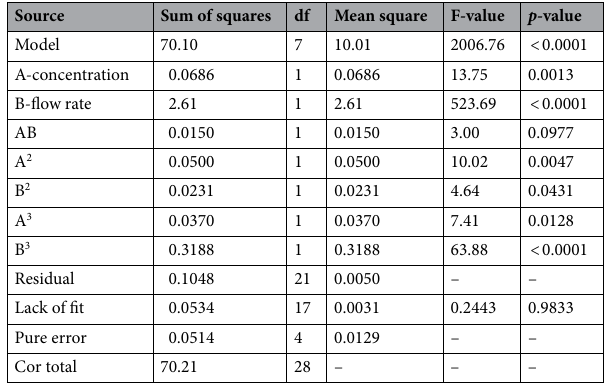
Table 12. The ANOVA table for Merkel number data of CFCT using TiO 2 nanofluid.